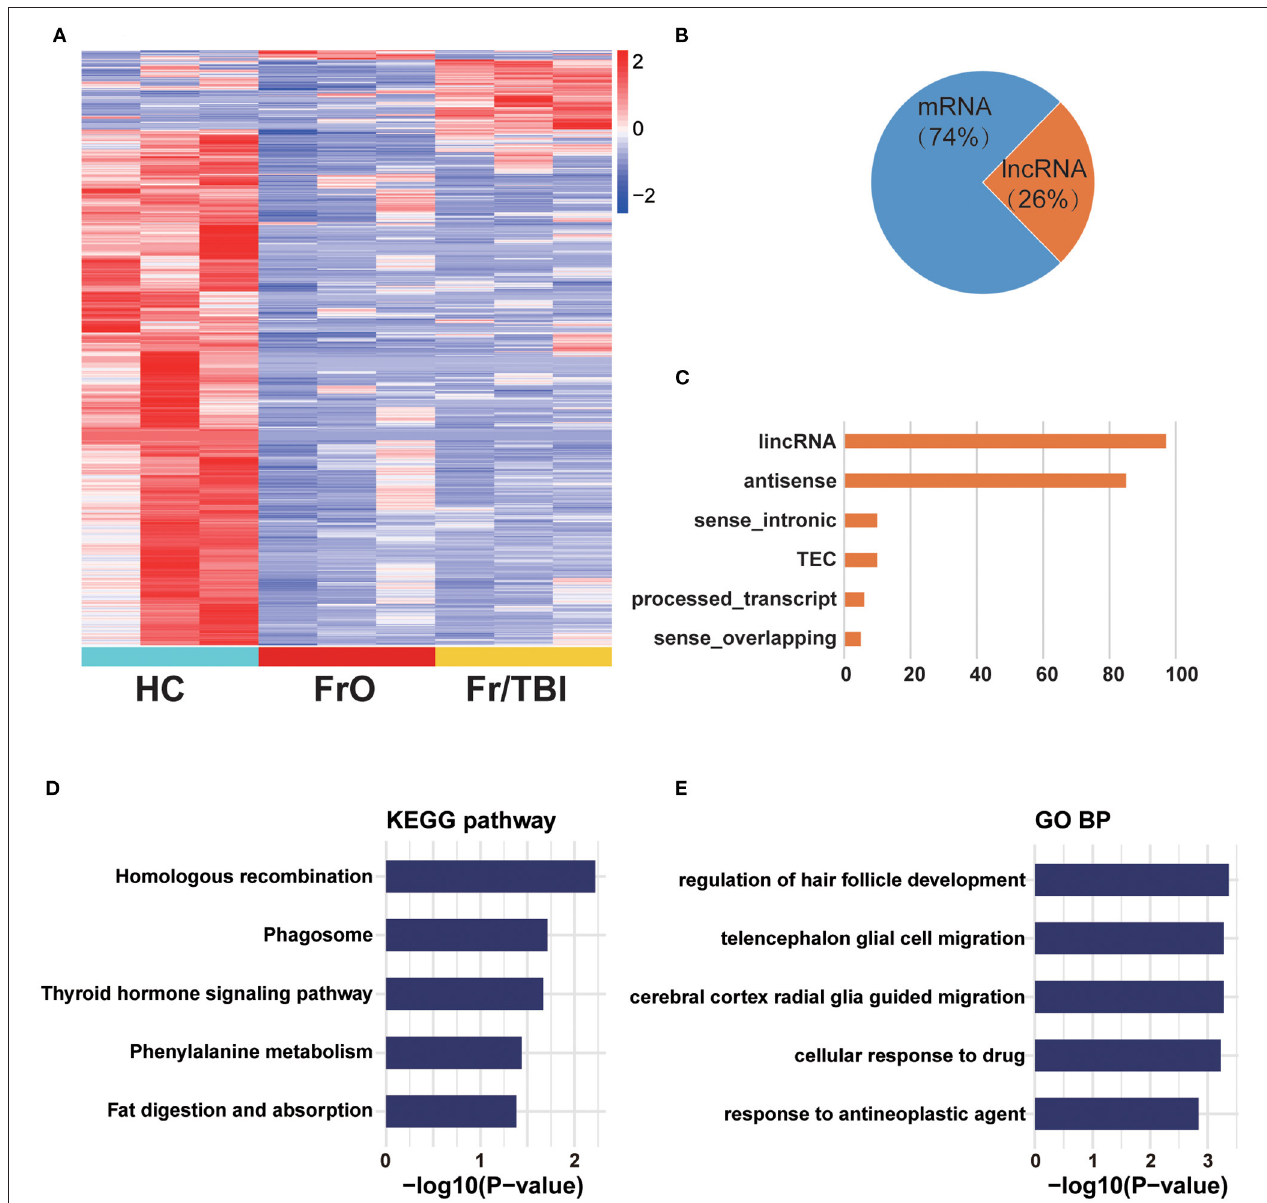
FIGURE 1 | Expression profile of sequence analysis. (A) Heatmap showed all differentially expressed genes from healthy volunteers and patients. (B) Composition of identified differentially expressed genes from long non-coding RNA (lncRNA) sequencing. (C) Counts of each lncRNA subtype of identified lncRNAs. lincRNA, large intergenic non-coding RNA; TEC, to be experimentally confirmed lncRNA. (D) Kyoto Encyclopedia of Genes and Genomes (KEGG) enrichment analysis of differentially expressed genes. (E) Gene Ontology (GO) enrichment analysis of differentially expressed genes.